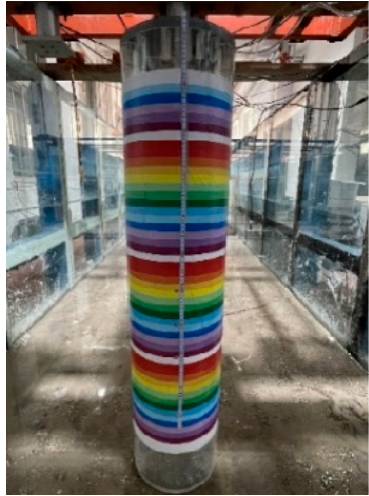
Figure 1. Photograph of the model monopile.